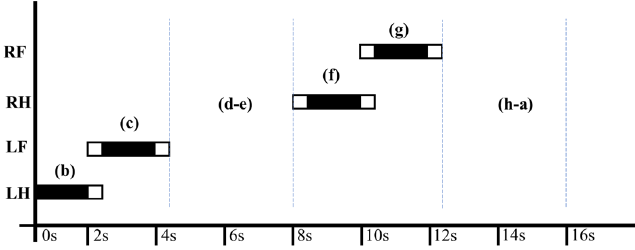
Figure 19. The motion of each leg and corresponding time for one locomotion cycle.